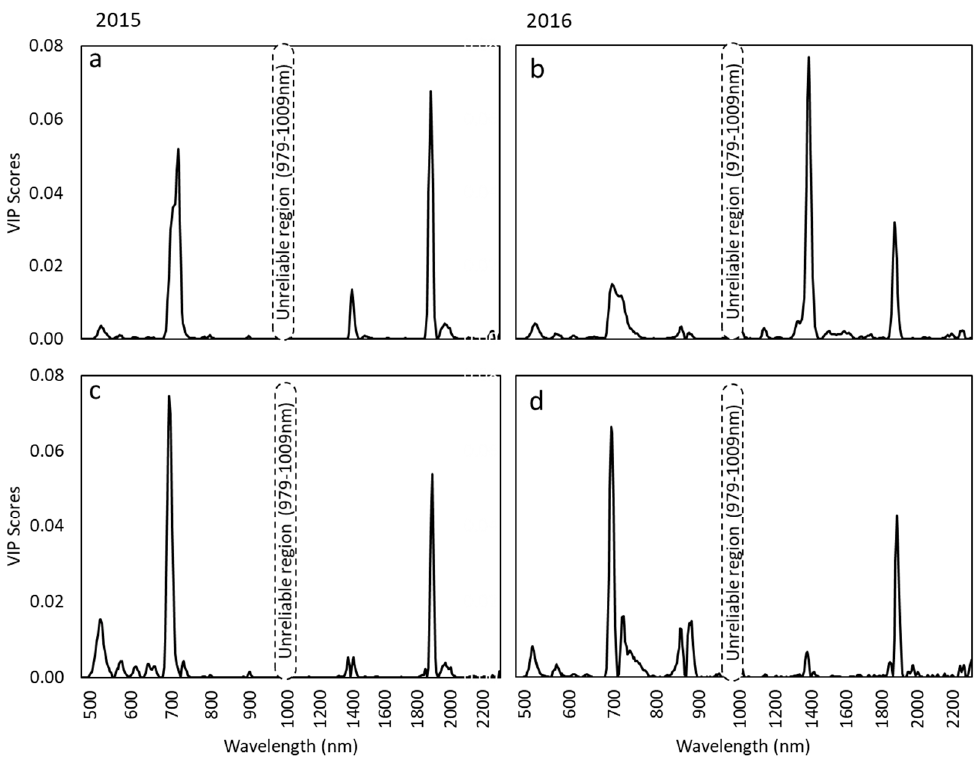
Figure 5. Contribution plot of DAPC indicating the wavelengths influencing the variation among the genotypes ( a ) Axis 1 2015 and ( b ) Axis 1 2016 and ( c ) Axis 2 2015 and ( d ) Axis 2 2016. The height of each wavelength is proportional to the contribution of the genotype separation to the first and second axis of the analysis, respectively. The only wavelength whose contribution was above a threshold (0.01) is the wavelength that contributed to the separation.